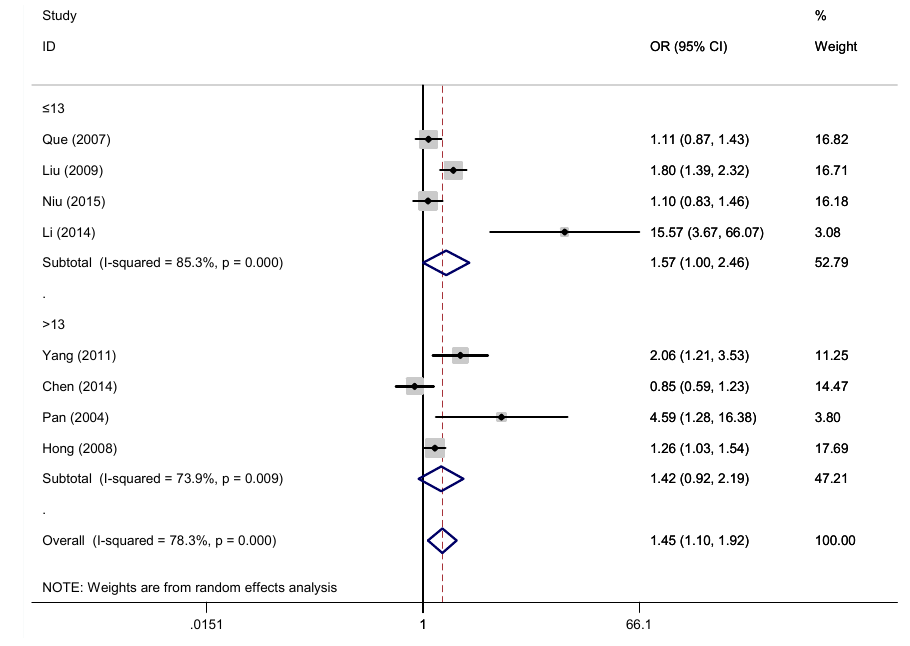
Figure 8. Subgroup analysis by age groups.